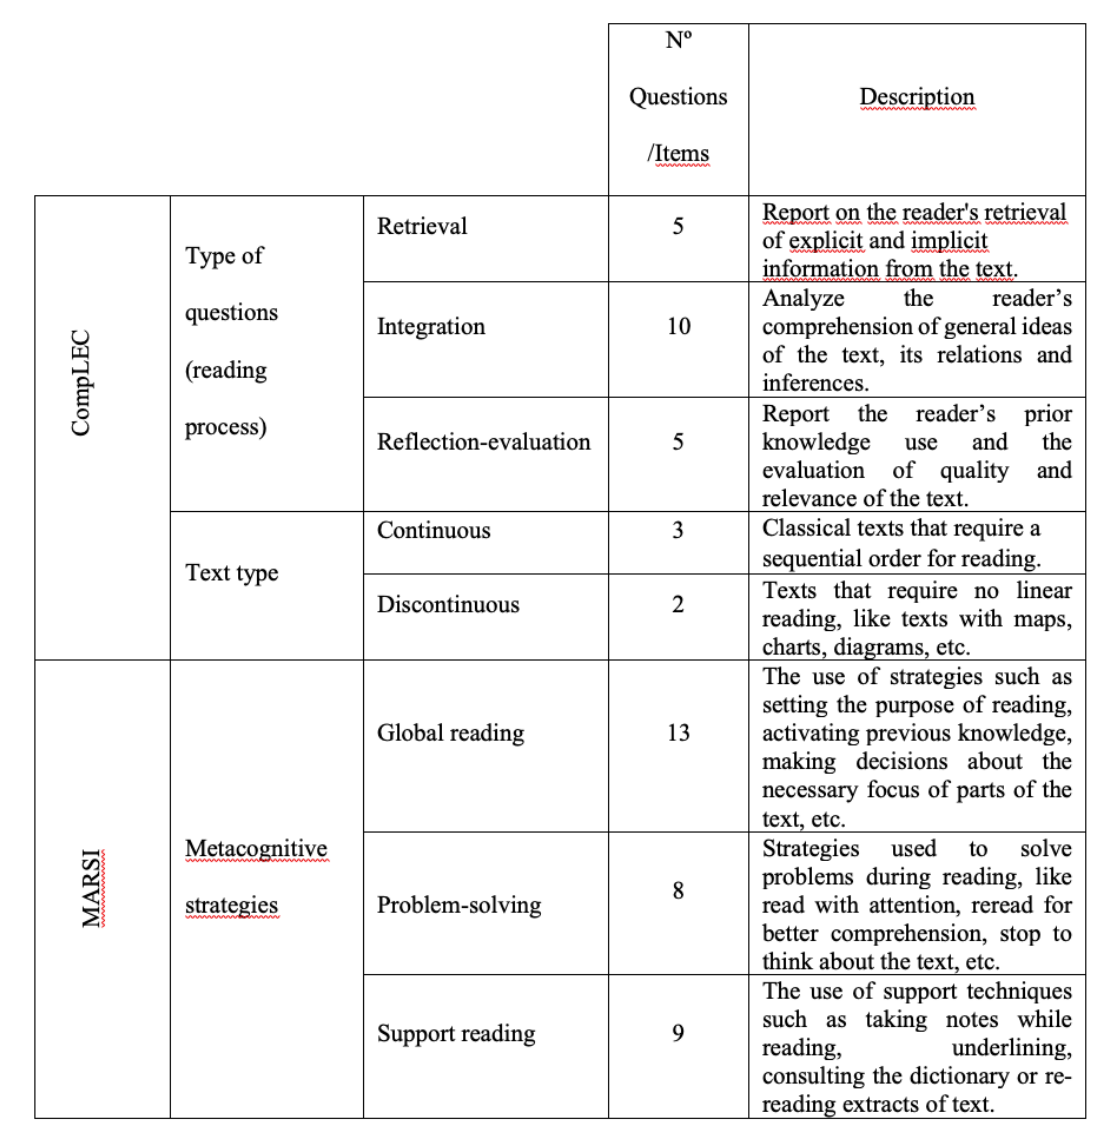
Table 1. Description of the study